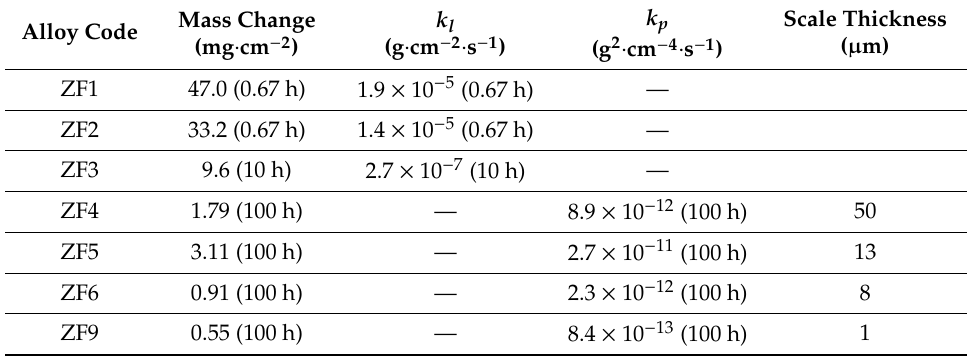
Table 2. Total mass changes and oxidation rate constants of the alloys at 800 ◦ C.